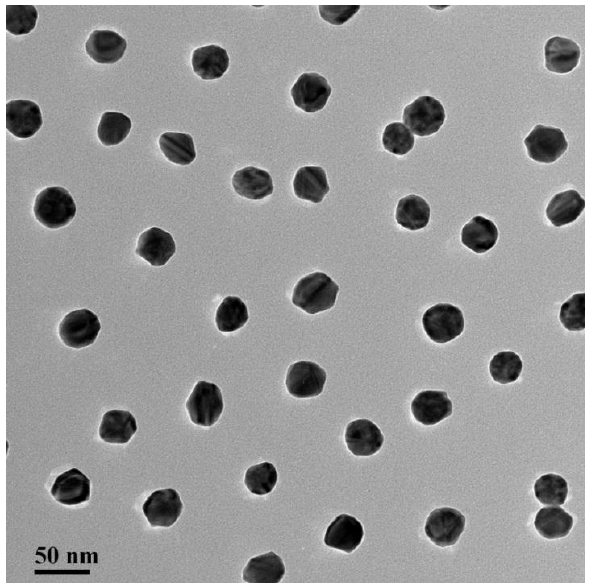
Figure 1. The TEM of colloidal gold nanoparticle (30